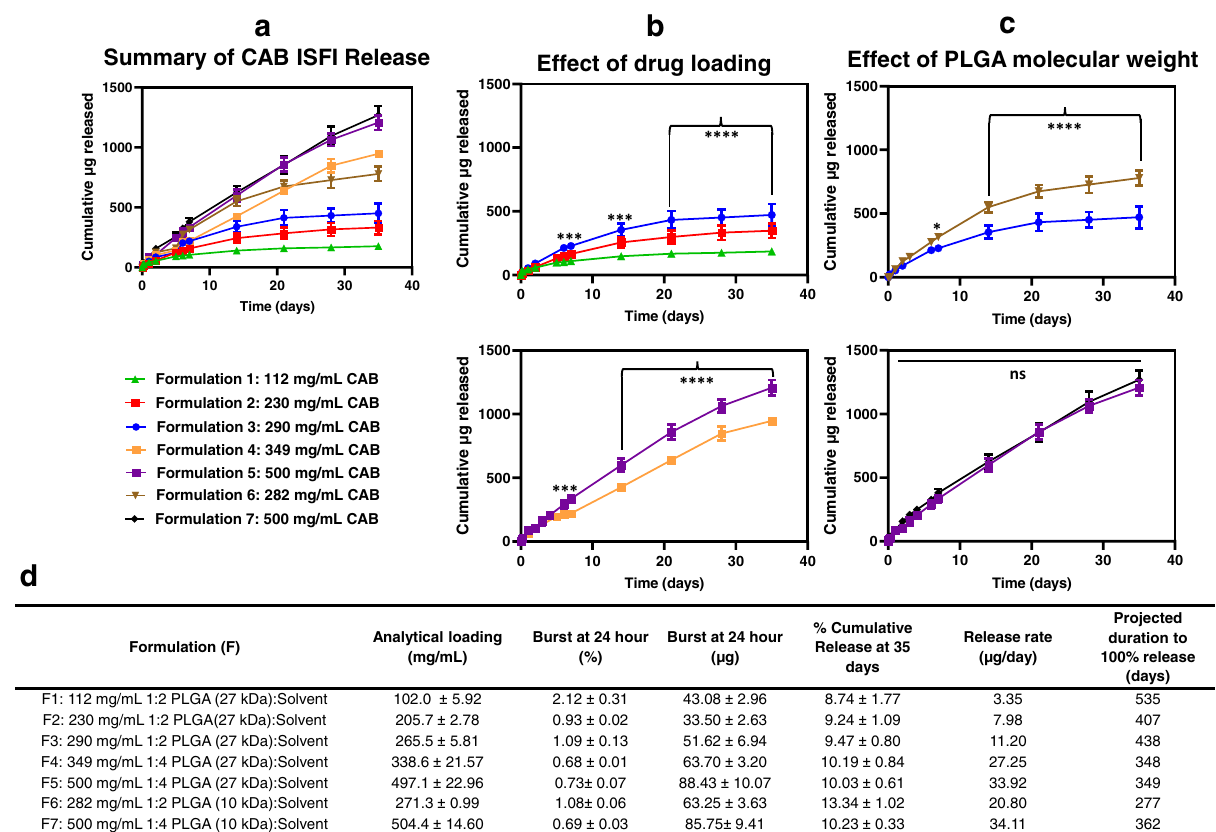
Fig.1|CABISFIcumulativeinvitroreleasekinetics.a CumulativereleaseofCAB ISFI formulations. b Effect of drug loading on cumulative CAB release. c Effect of PLGAmolecularweightoncumulativeCABrelease.Allinvitroreleasestudieswere done in phosphate buffer saline (PBS, pH 7.4 with 2% Solutol) at 37°C. Data pre- sented asaverage±standarddeviationfor n =3 samples. Sourcedata are provided